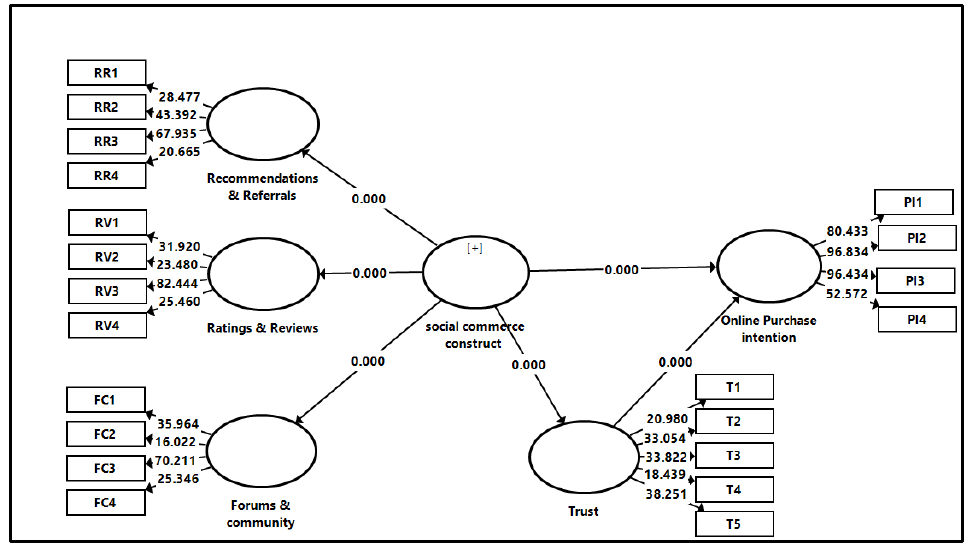
Fig. 2. Path Analysis